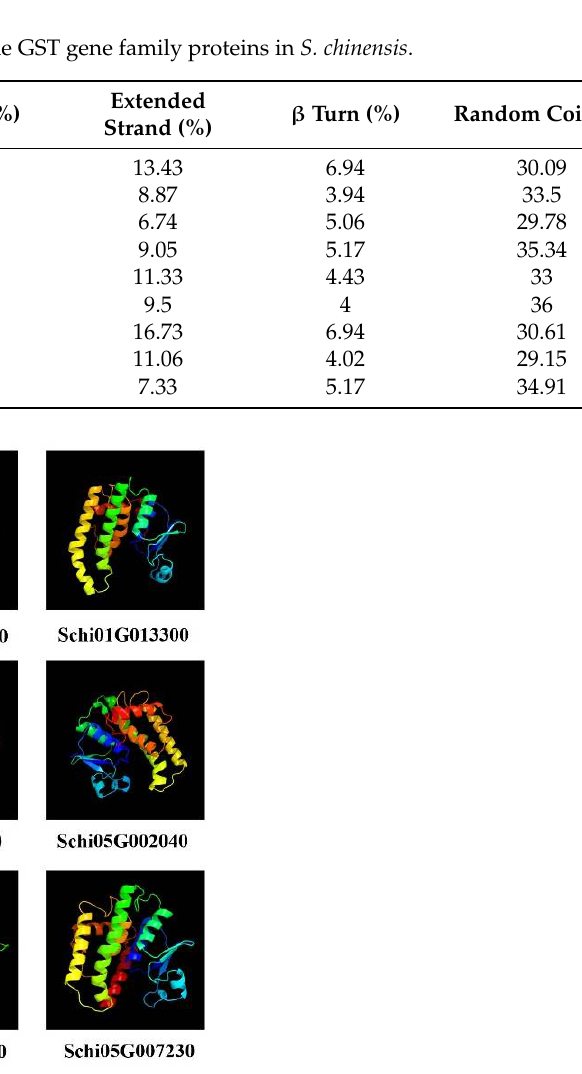
Figure 8. Prediction of tertiary structures of GSTs proteins in S. chinensis.